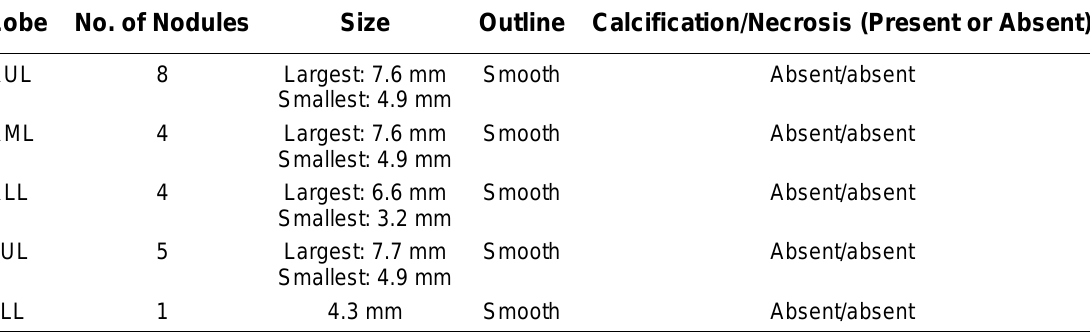
CT Scan of Nodules in the Lung